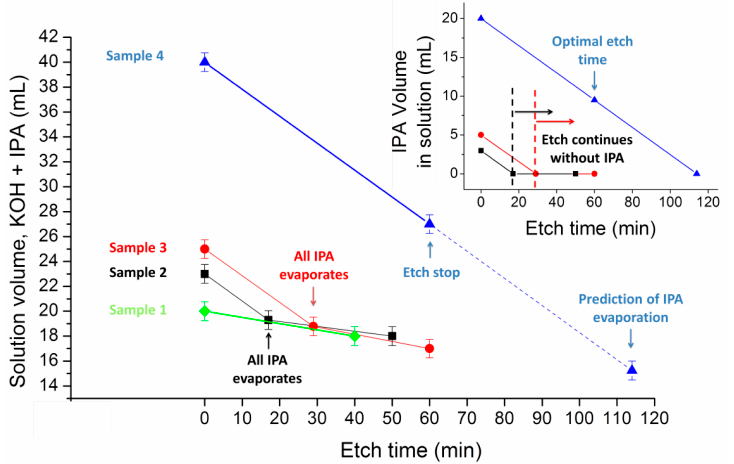
Figure 4. Evolution of solution volumes as a consequence of solvent evaporation. The main chart represents the volume of the whole solution (water and IPA) and the inset chart represents the IPA volume evolution, during the etch process. Sample 1 (green); Sample 2 (black); Sample 3 (red); and Sample 4 (blue).